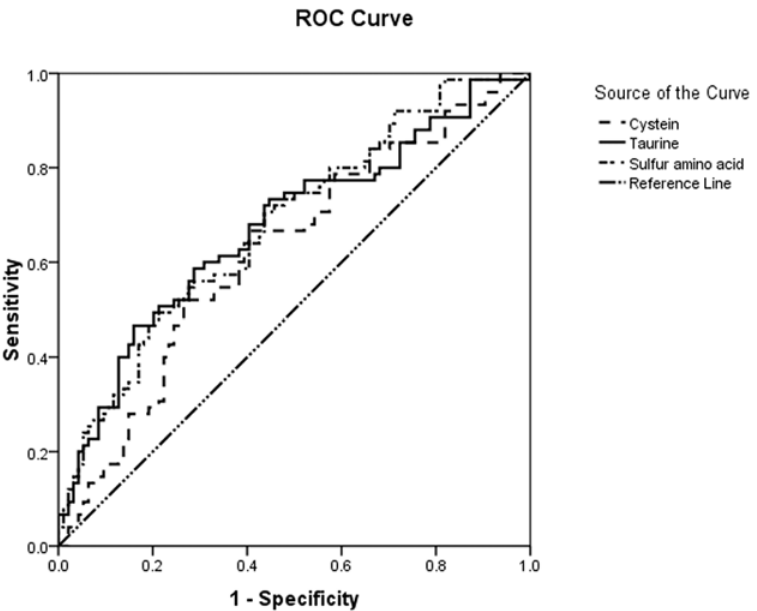
Fig 5. ROC curves for the outcome prediction value of the cystine, taurine, and sulfur-containing amino acid levels and the APACHE II and SOFA scoring systems at all time points post-admission. Sensitivity means true positive rate; 1-specificity means false positive rate; the 45-degree reference line stands for the chance diagonal, which means a diagnostic test is completely free of diagnostic value (the area under the curve equals 0.5).